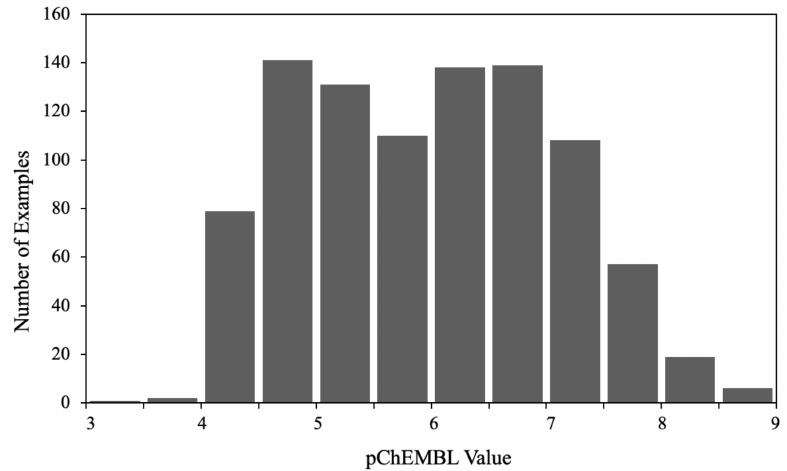
Figure 1. Distribution of the activities of the molecules in the